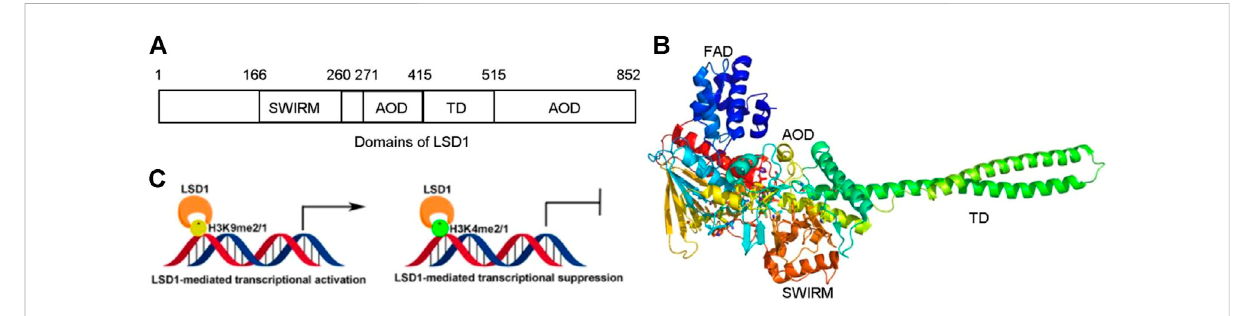
FIGURE 1 Structure and function of LSD1. (A) Distribution of domains of LSD1. (B) LSD1-mediated transcriptional modulation. (C) Overview structure of